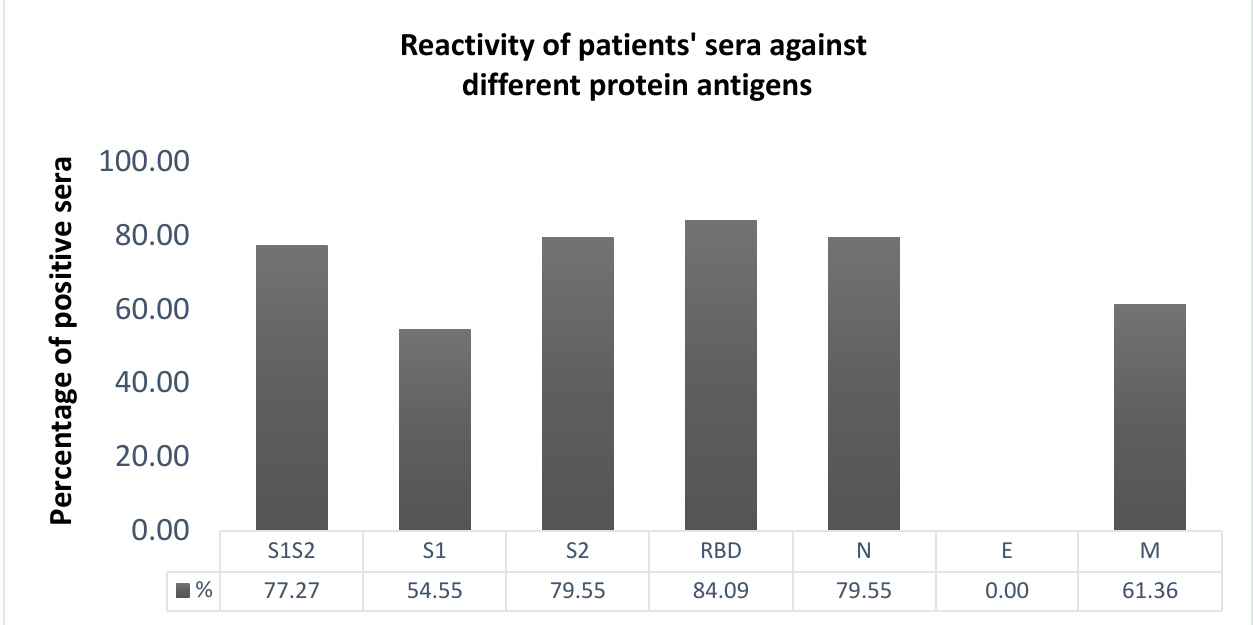
Figure 2. Prevalence of antibodies against different protein antigens in patients’ sera. The pre-COVID-19 controls were used to establish the background reactivity to the protein antigens for IgG antibodies. The cut-off value for each antigen was determined using the mean optical density plus 2 SDs of normal controls. Sera that yielded an OD value above that cut-off was considered as positive.